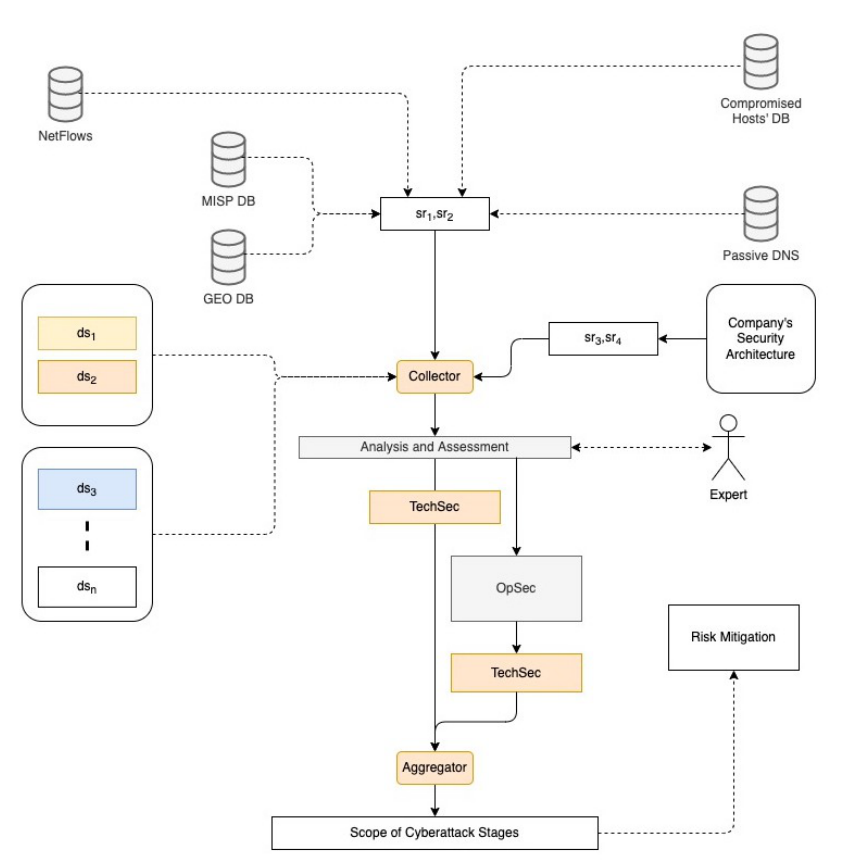
Figure 4. Proposed method for identifying the scope of cyberattack